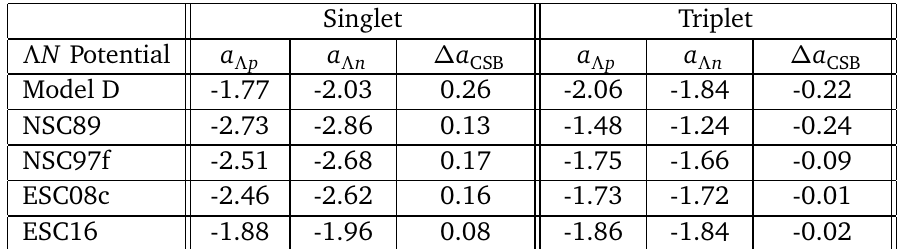
= a − a Λ p Λ n CSB